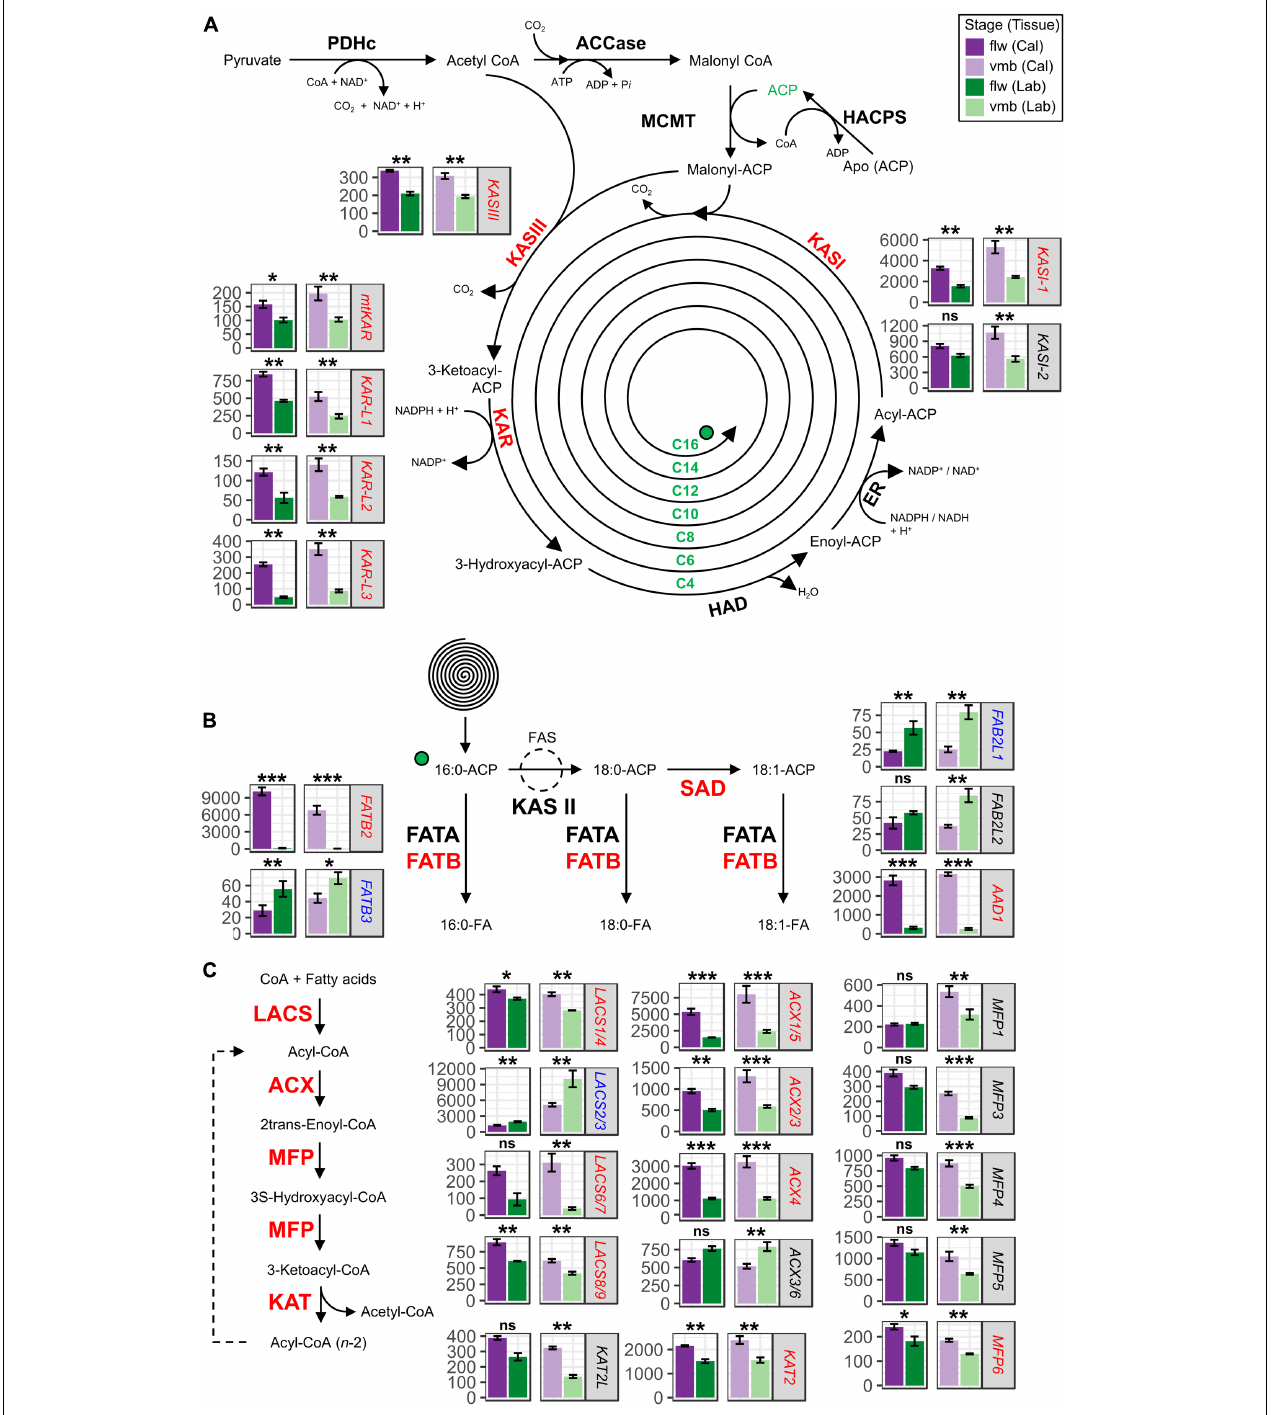
FIGURE 3 | Expression of transcripts involved in the fatty acid (FA) biosynthesis and degradation pathways in labellum and callus tissues of vmb and flower developmental stages. Differentially expressed transcripts encoding enzymes involved in (A) FA synthesis and subsequent (B) elongation and desaturation in the plastids as well as (C) β -oxidation (degradation) in the peroxisome are depicted. Values are normalized transcript counts ± standard error. Dark purple, light purple, dark green, and light green depict callus tissue of flower stage, callus tissue of vmb stage, labellum tissue of flower stage, and labellum tissue of vmb stage, respectively. False discovery rate significance levels in each contrast are represented with symbols ∗ (0.05 > FDR > 0.01), ∗∗ (0.01 > FDR > 1.0 E –10), ∗∗∗ (FDR < 1.0 E –10). ns represent non-statistically significant differential expression (FDR > 0.05). Biochemical reactions bolded in red depicts general modulation (upregulated or downregulated) consistency in underlying